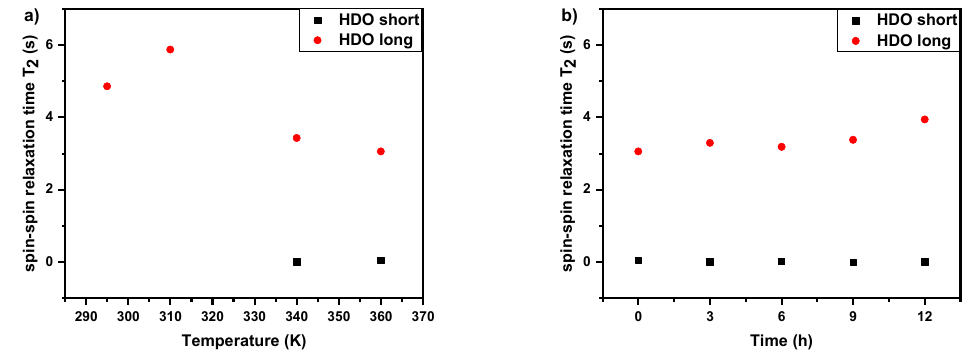
Figure 9. Temperature dependence ( a ) and time dependence at 360 K ( b ) of 1 H spin–spin relaxation times T 2 of HDO in D 2 O solution ( c = 5 wt%) of the P(MeOx/EtOx)(7/93) copolymer.